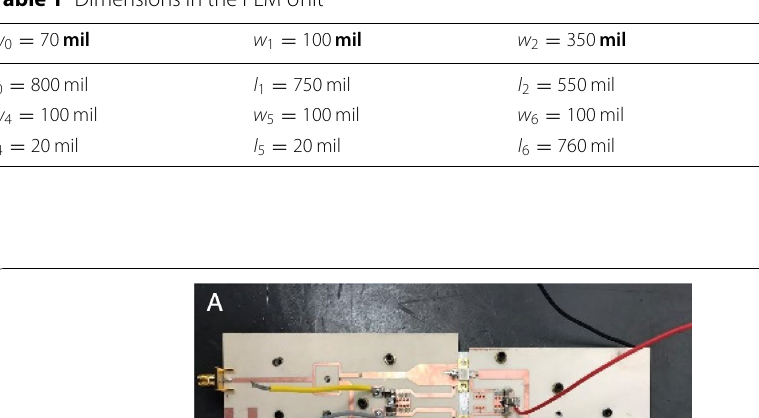
The drain voltage supply is 28 V. At the junction where the main PA and auxiliary PA combine in each of the PLM unit, the optimum output load impedance is designed 25 (cid:31) . A Chirex power combiner as shown in Fig. 6 is used to combine to be Z opt = the two PLM channels. The impedance of the quarter wavelength lines between the √ 2Z PA output and the combiner point is opt = 35.4 (cid:31) . On the right hand side of the combining point, another 35.4 Ω quarter wavelength line is used to match the out- put impedance to 50 Ω. The complete module is terminated with a cavity filter with 30 MHz bandwidth centered at 1.995 GHz. Between the cavity filter and the com - biner, a certain length of 50Ω line is employed to create open-circuit termination to the PA at the cavity filter stopband [7].